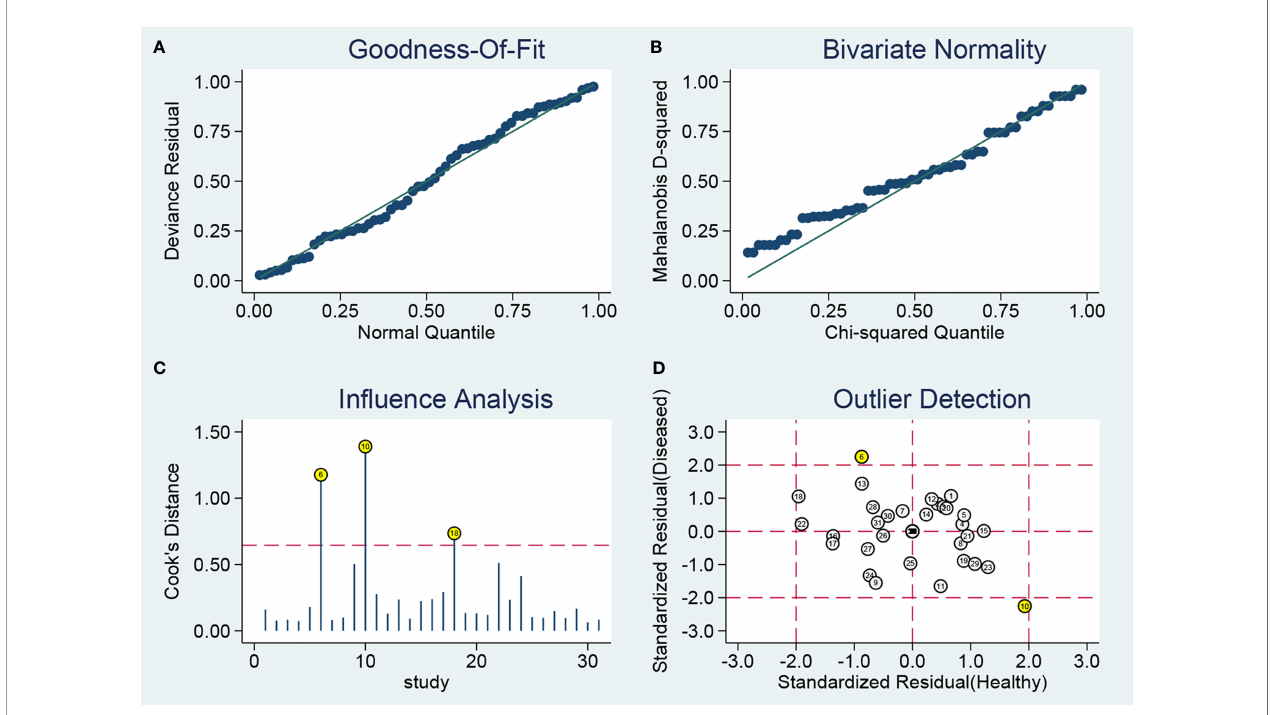
FIGURE 4 | Sensitivity analysis results. (A) Goodness-Of-Fit; (B) Bivariate Normality; (C) In fl uence Analysis; (D) Outlier